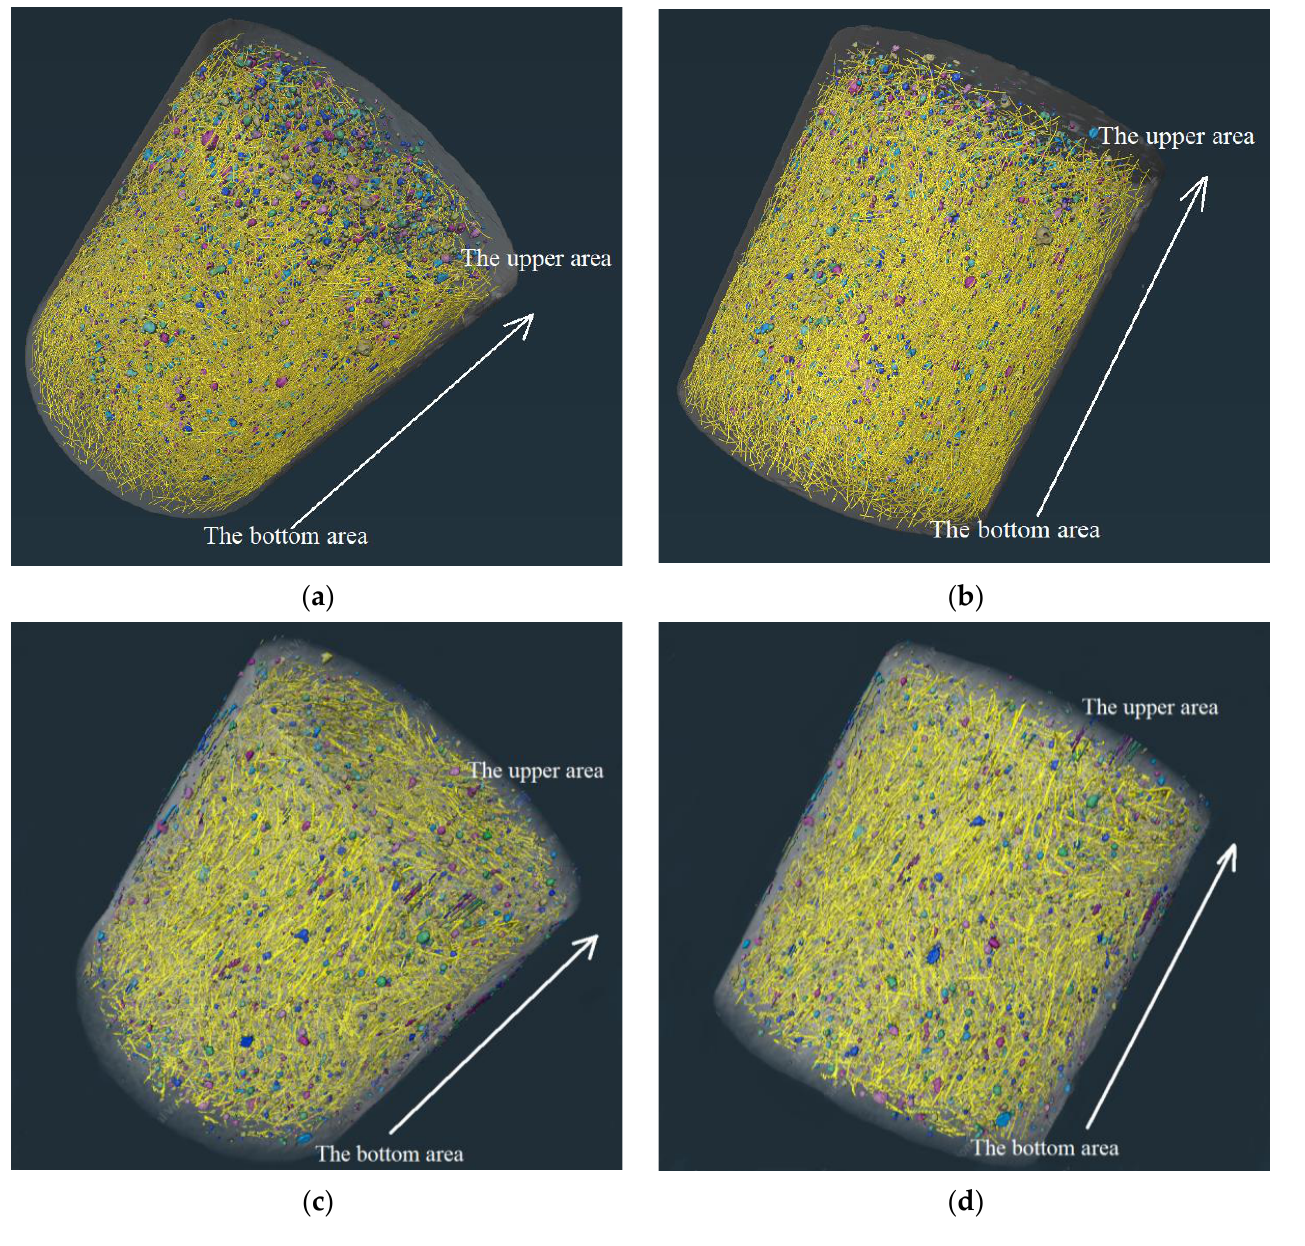
Figure 15. Differences of UHPC prepared with seawater sea sand and freshwater river sand: ( a ) SSUHPC, vertical view; ( b ) SSUHPC, side elevation; ( c ) FRUHPC, vertical view; ( d ) FRUHPC, side elevation.